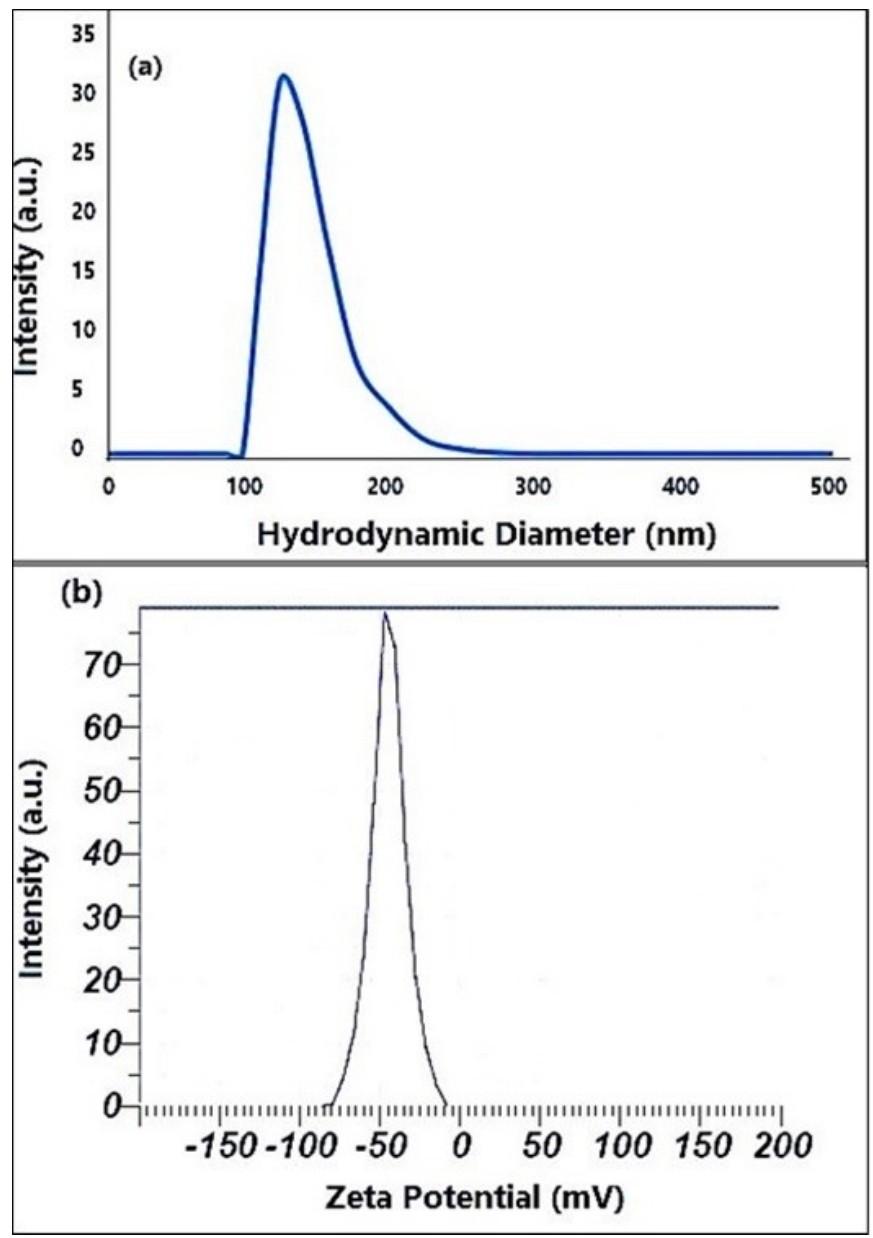
Figure 3. ( a ) The size distribution of prepared ZnO NPS by dynamic light scattering DLS. ( b ) Zeta potential value of prepared ZnO NPS.